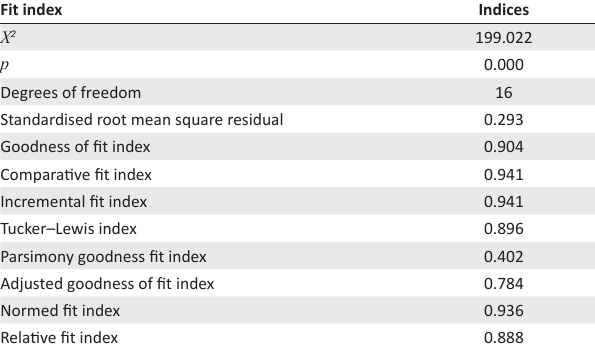
TABLE 3: Structural model fit summary.